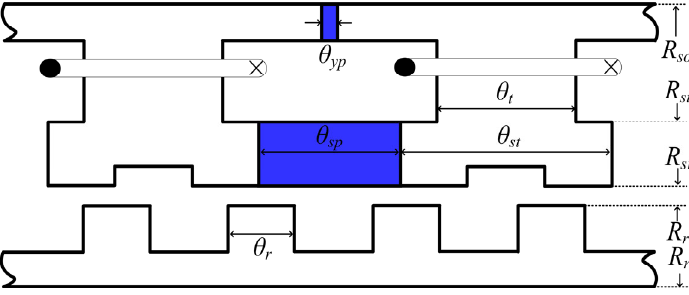
Figure 3. Parametric model of a multi ‐ tooth HE ‐ DSDPM.